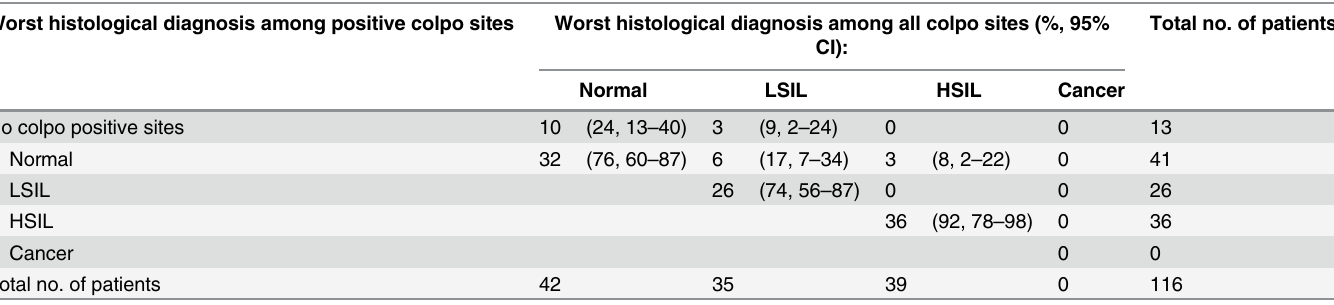
Table 9. Comparison of worst histological diagnosis among sites diagnosed as positive by colposcopy with worst overall histological diagnosis for the 116 Vancouver diagnostic patients with a negative study Papanicolaou smear diagnosis. Worst histological diagnosis among positive colpo